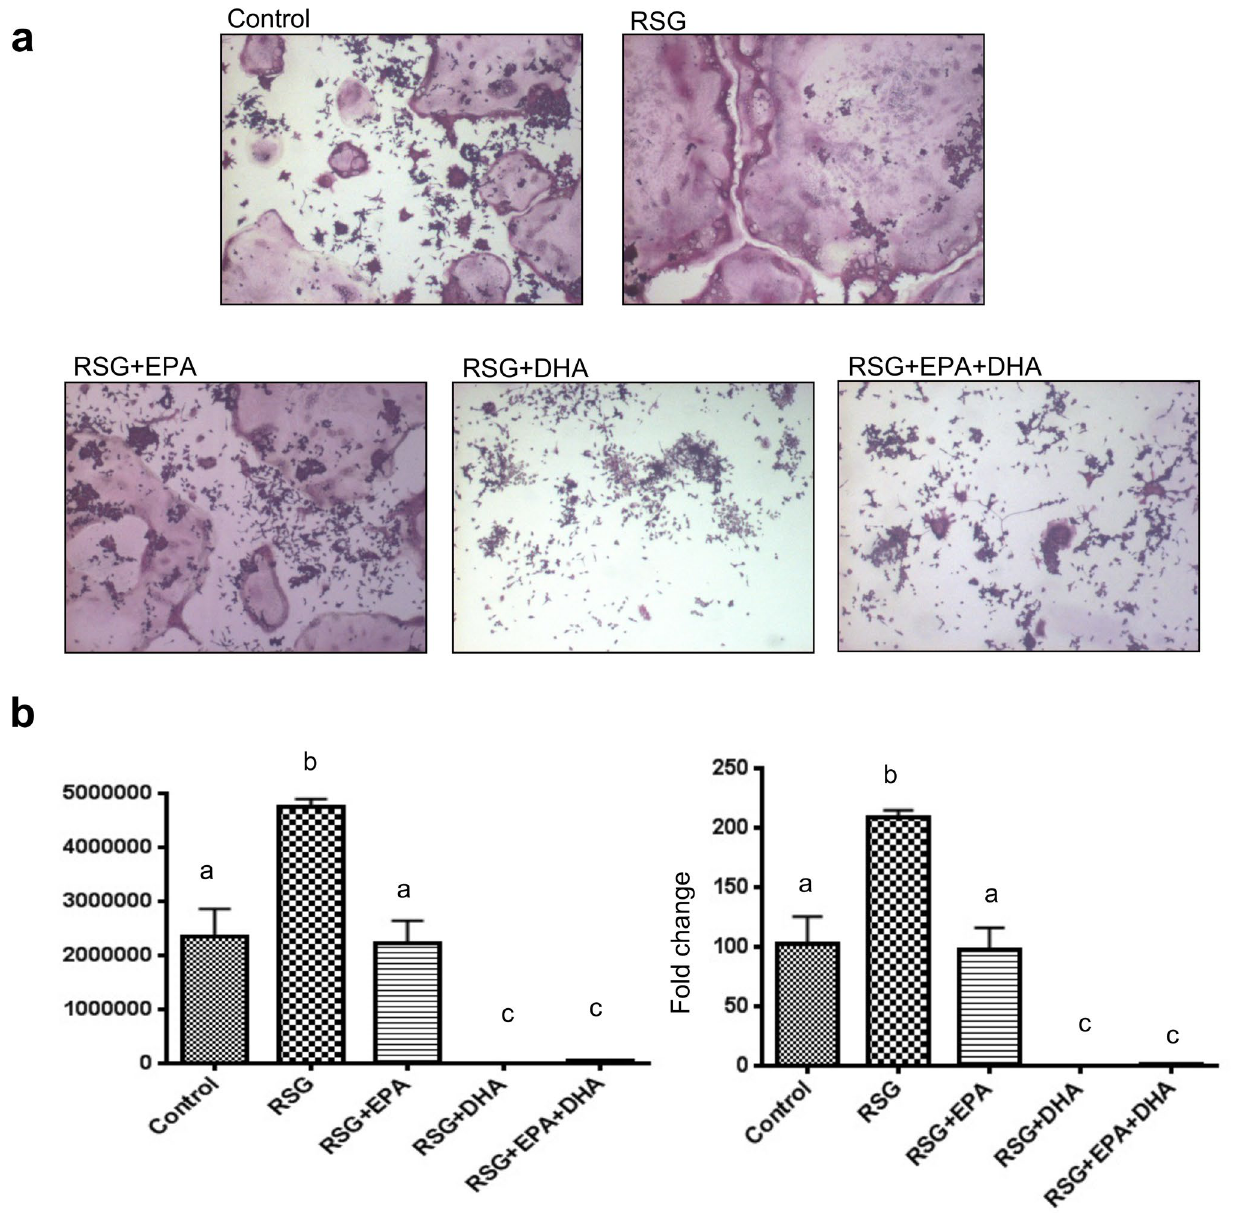
Figure 2. Effect of RSG with or without omega-3 FAs on osteoclastogenesis in RAW 264.7 cells. RAW 264.7 cells were cultured with RANKL 50 ng/mL in the presence of RSG 1 µM with or without EPA 10 µM and/ or DHA 10 µM for 5 days. At the end of the cultures, cells were fixed and stained for tartrate-resistant acid phosphatase (TRAP). The number of TRAP-positive multinucleated cells (MNCs) (more than 3 nuclei) was counted as osteoclast-like cells in each well. Representative photographs (20×) of TRAP-positive MNCs ( a ). Optical Density (OD) intensity was determined by histomorphometry using the Metaview Image Analysis System software for the TRAP-positive area ( b ). Each bar represents the mean ± SEM of two independent quadruplicate cultures. Value with different superscripts is significantly different at p < 0.05 by Newman– Keuls one-way ANOVA with multiple comparison test. RSG rosiglitazone, EPA Eicosapentaenoic acid, DHA Docosahexaenoic acid, RANKL Receptor activator of nuclear factor kappa-Β